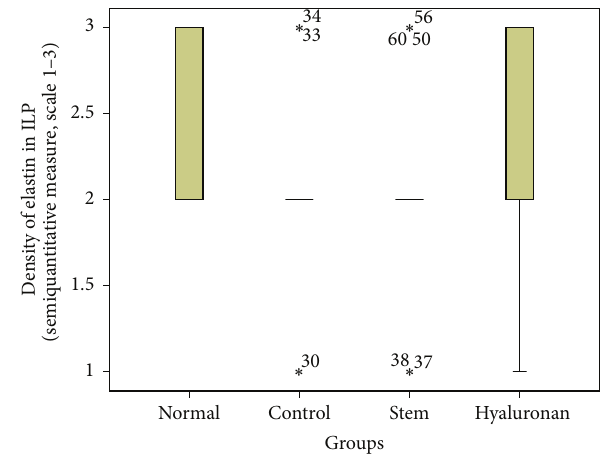
Figure 16: Density of collagen in the deep lamina propria (DLP). Normal = normal/control group, control = scarred/control group, stem = stem cell group, and hyaluronan = hyaluronan group.